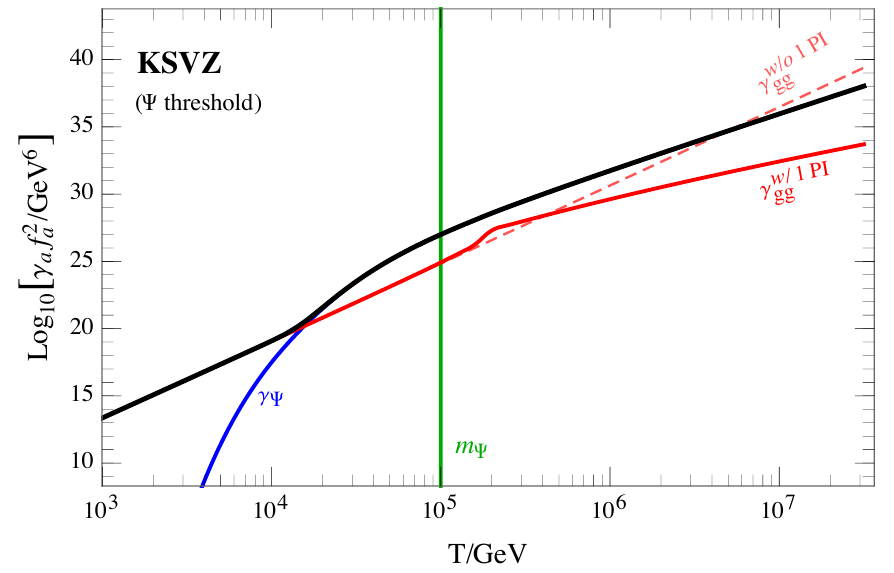
Figure 2 . KSVZ axion production rate across the heavy colored PQ fermion mass m Ψ = 10 5 GeV . The black solid line indicates the total rate, and it is the sum of Ψ scatterings (solid blue) and thermal gluon scattering (solid red). We show for comparison the gluon scattering rate obtained with only the Wilsonian action contribution (dashed